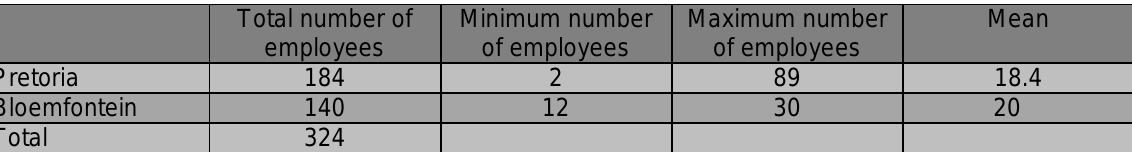
Table 2: Total number of employees working on the buy-back centre sites (Pretoria n=10; Bloemfontein n=7 Total number of Minimum number Maximum number Mean employees of employees of employees Pretoria 184 2 89 18.4 Bloemfontein 140 12 30 20 Total